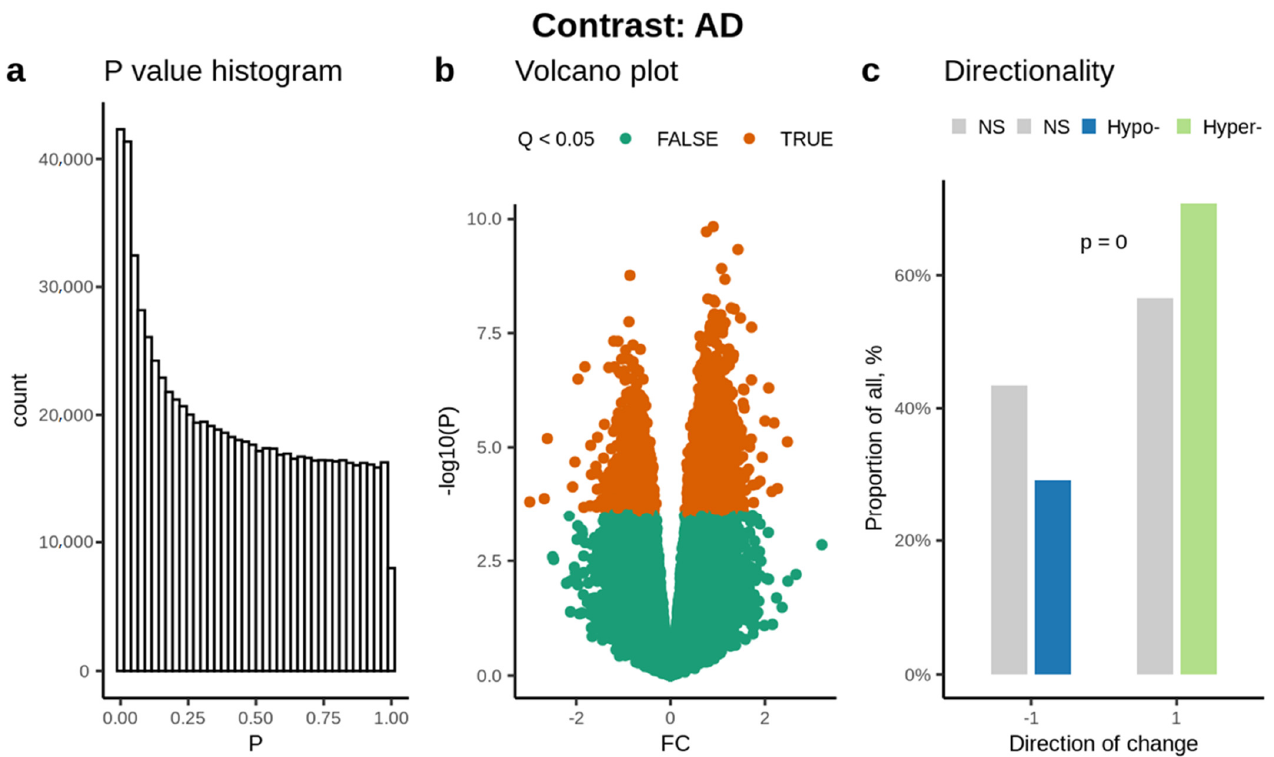
Figure 2. A linear model of DNA methylation in association with cell free circulating DNA in Alzheimer’s disease: Robust linear models fitted to the DNA methylation data using Age, Sex, NeuN proportion and Sentrix ID as covariates ( a ) Histogram based on p -value, showing CpGs being less than 0.05, ( b ) Volcano plot showing CpGs being less than 0.05 (orange colored nodes), ( c ) Overview of the methylation status of CpGs: the highest number of hyper-methylated CpGs (Green bar) were identified compared to hypo-methylated CpGs (Blue bar). The non-significant CpGs are presented using a grey scale.